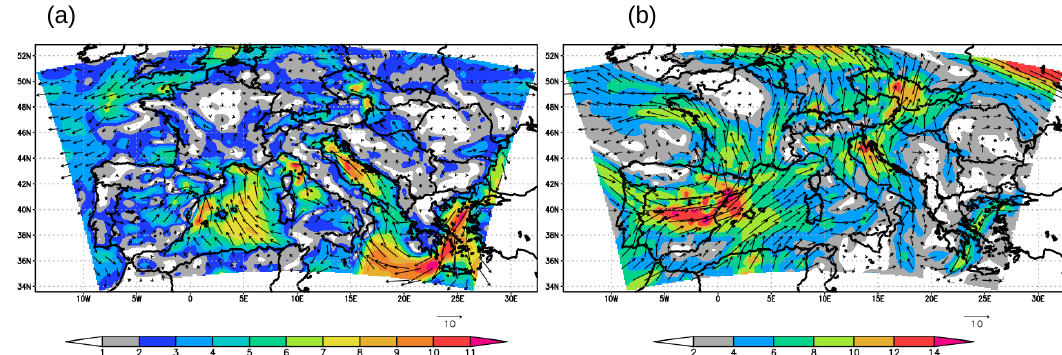
Figure 2. 10 m, panel ( a ), and 850 hPa, panel ( b ), wind fields (magnitude and vector, m s − 1 ), referred to 00 UTC, 3 October 2015, produced by the Global Forecast System model.